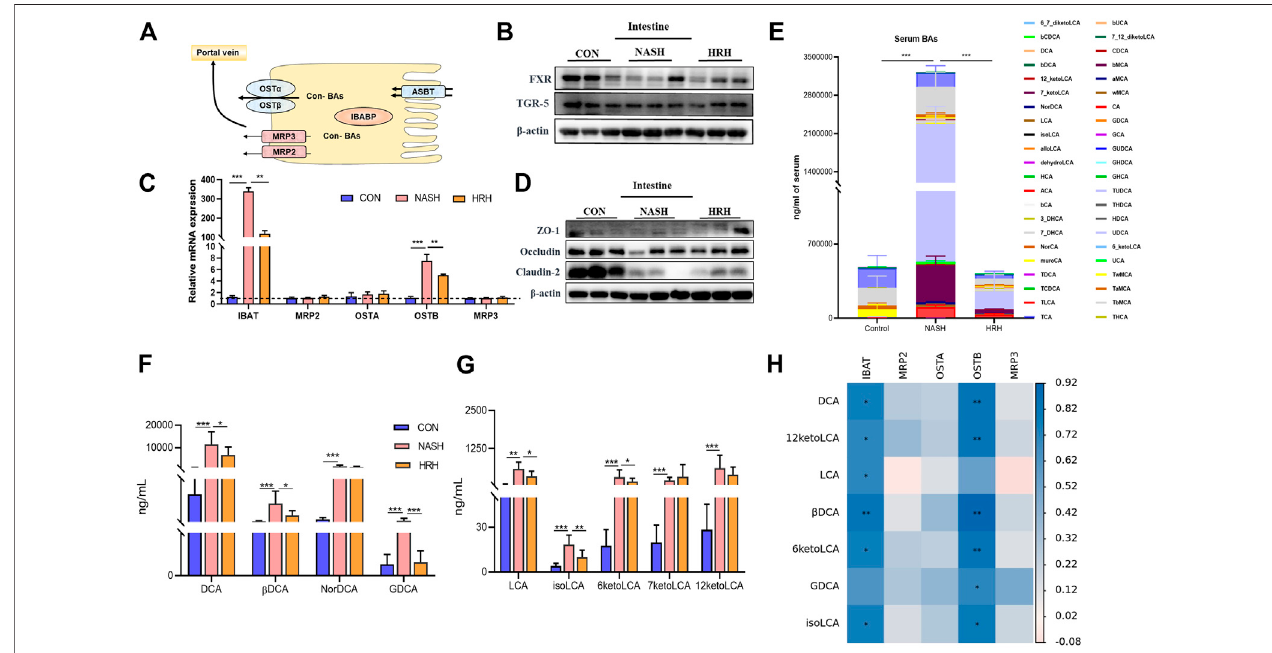
FIGURE 5 | HZRG inhibits BA reabsorption. (A) The model of BA transport in the intestine; (B) The protein expression of intestinal BA receptors; (C) The mRNA expression of BA transporters; (D) Intestinal tight junction protein expression; (E) Serum BA pro fi le; (F,G) The alteration of secondary BA species; (H) The correlation of altered secondary BAsandthegenesregulatingBAtransport. Dataareexpressed asmean±SD, n =10pergroup. * p < 0.05,** p < 0.01;*** p < 0.001betweengroups.